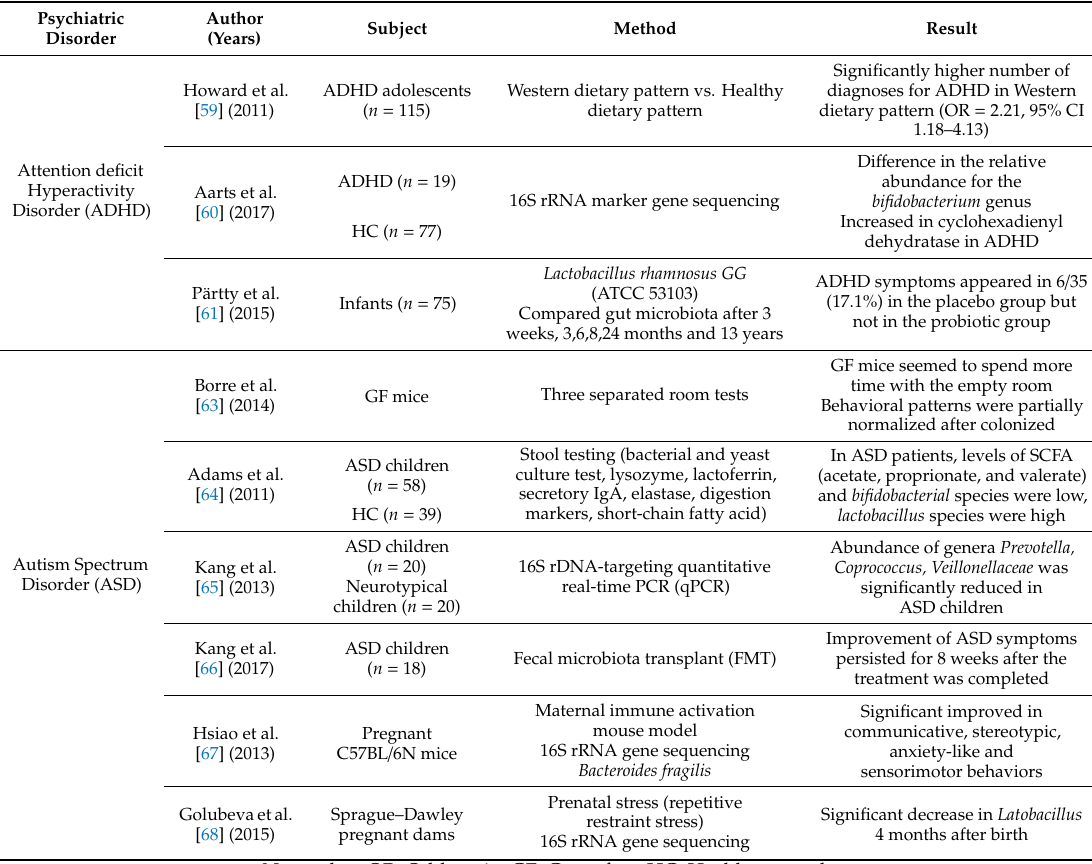
Table 2. Characteristics of prior studies investigating the relationship between microbiome and Attention Deficit Hyperactivity Disorder, Autism Spectrum